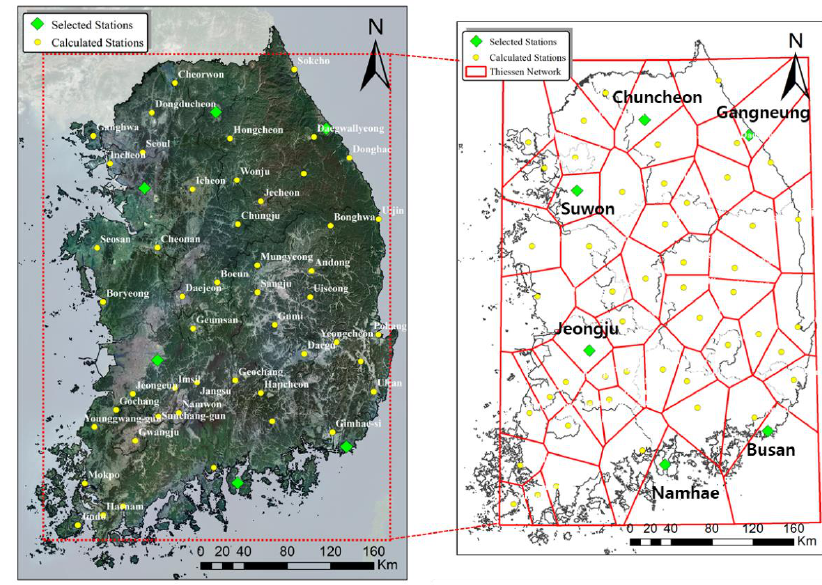
Figure 2. Weather stations in the study area.